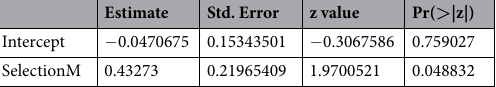
Table 2. Results of logistic regression performed on the data obtained from the assay for assortative mating. Successful mating between WR individuals was used as the response variable. Selection regime was used as fixed effect and replicate population nested within Selection regime was used as random